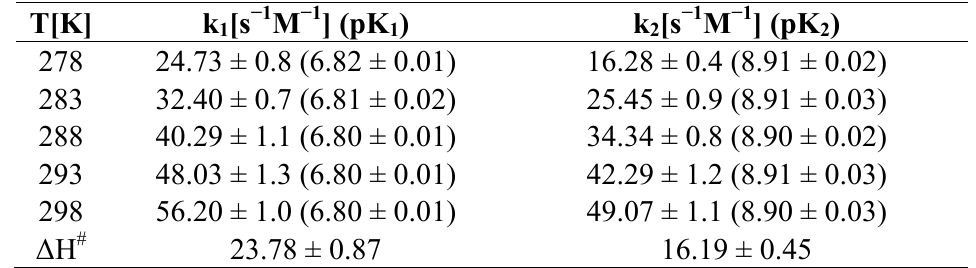
and K ) for the reaction of 1 2 )(OH ) ] + cation (first step) 2 2 2